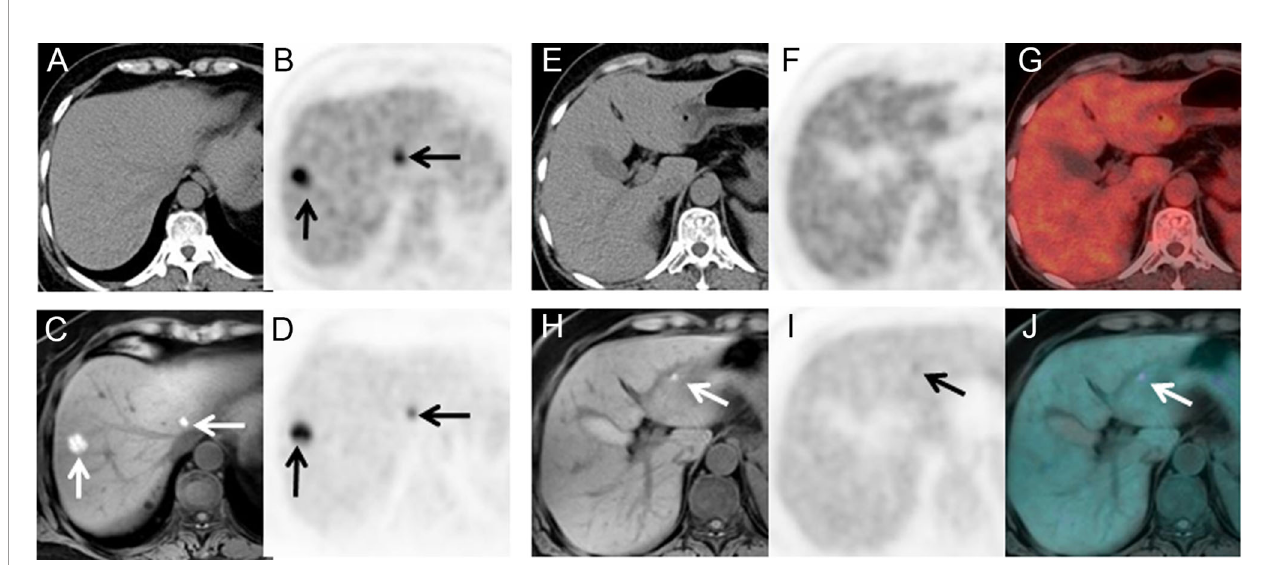
FIGURE 4 | A 66-year-old female with surgical resection of malignant melanoma on head skin. She received PET/CT scans as regular follow-ups. Only two lesions were seen on PET/CT (A, B) . No lesion was seen on the left lateral lobe (E – G) . PET/MR clearly showed two lesions with hyperintensity on T1WI and hypermetabolism (C, D) , and an additional 4-mm small lesion was identi fi ed on T1WI and PET (H – J) , which only showed mild FDG uptake (T/N =